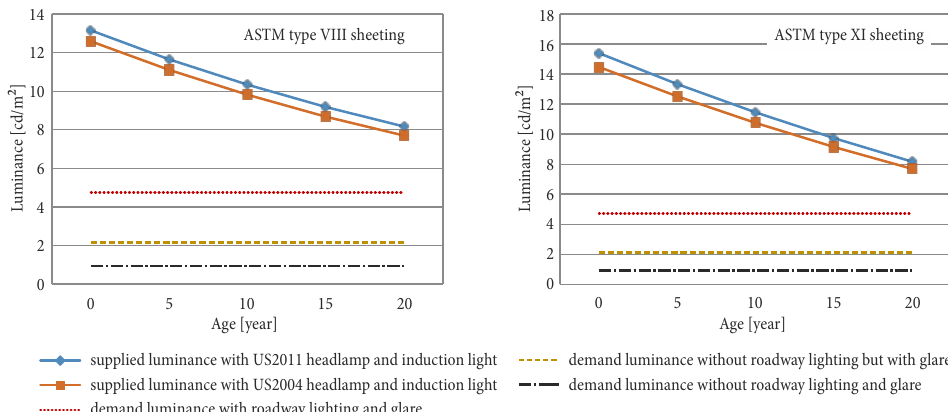
Fig. 5. Supplied luminance with induction lights vs. legibility luminance for